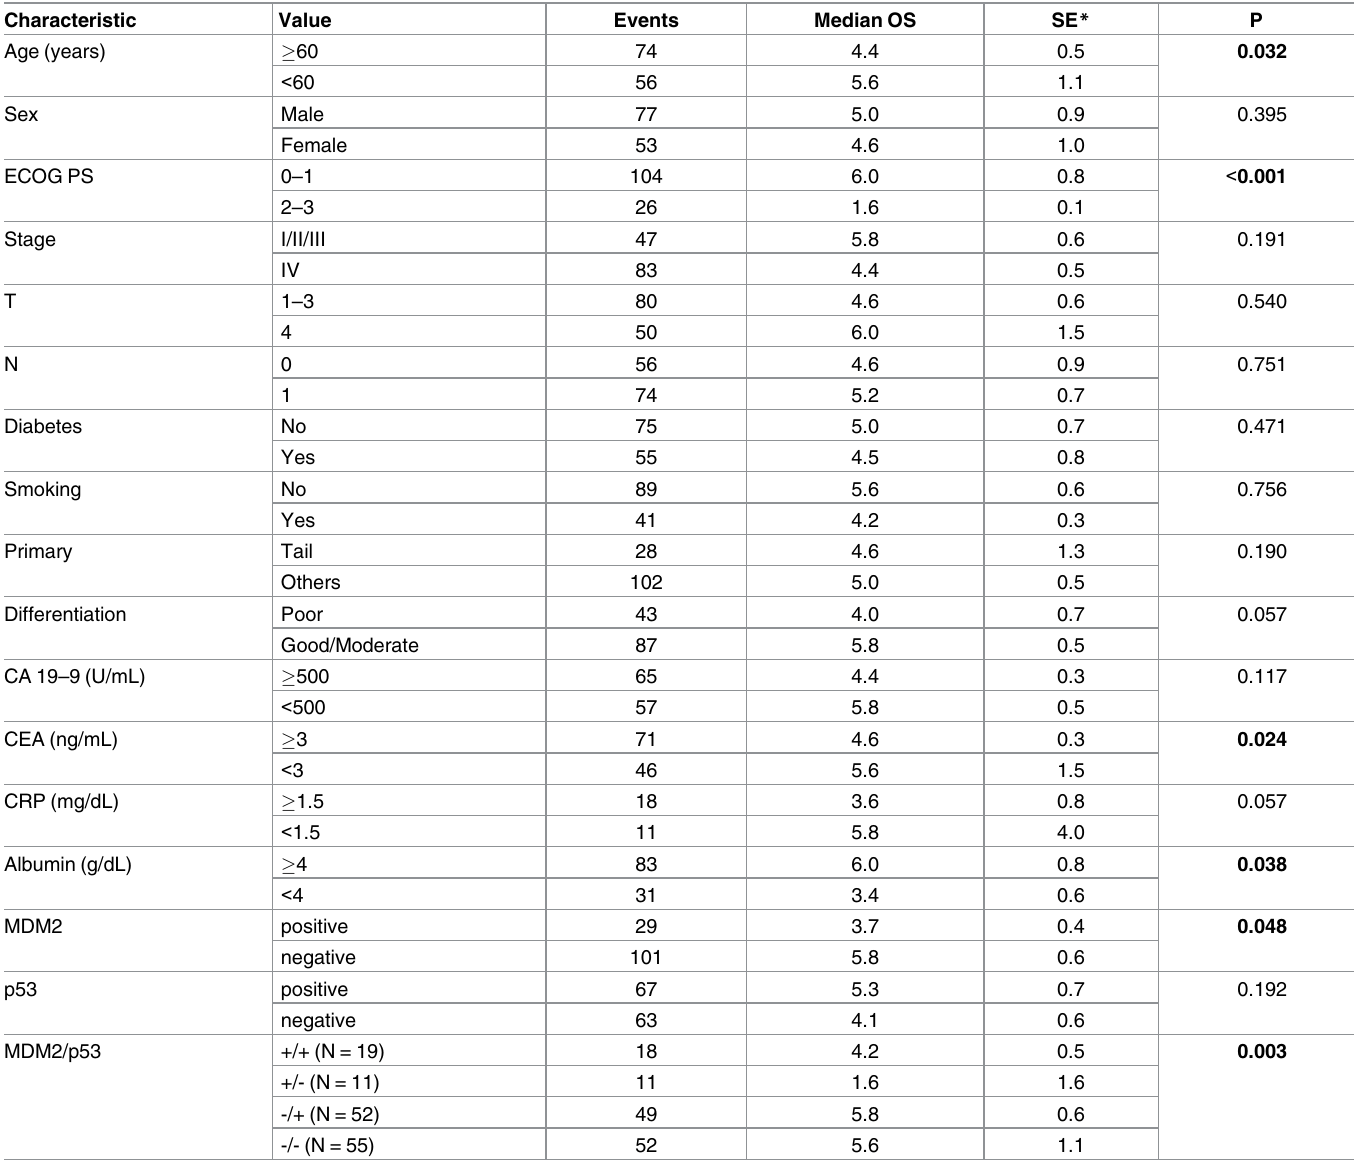
Table 2. Univariate analysis for